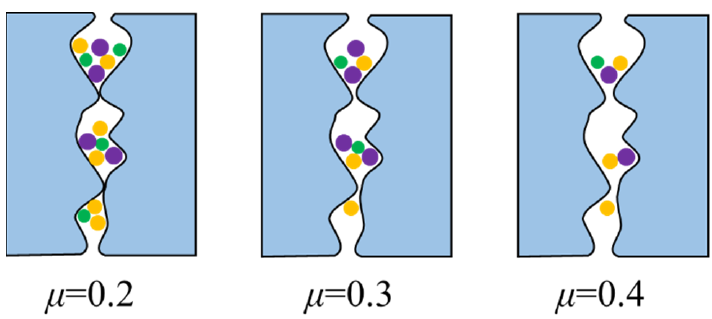
Figure 9. Schematic diagram of fracture change induced by non-uniform coefficient (the colorful circles represent mineral filler and other inclusion in fracture of coal).